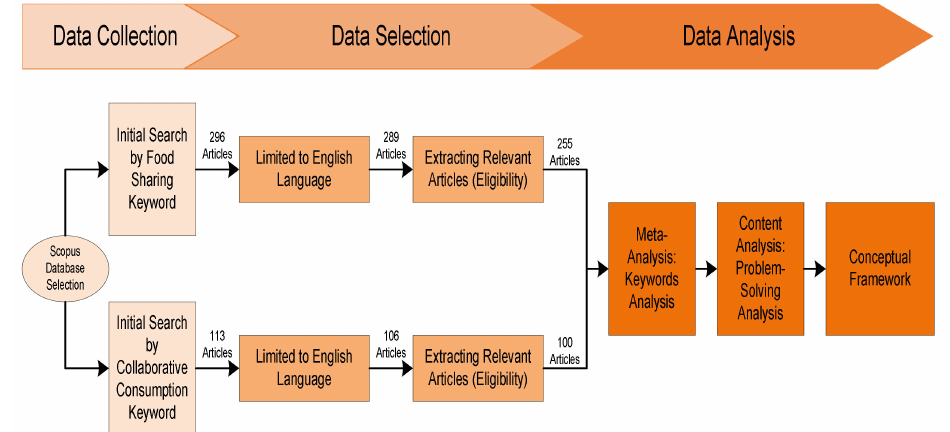
Figure 1. Research